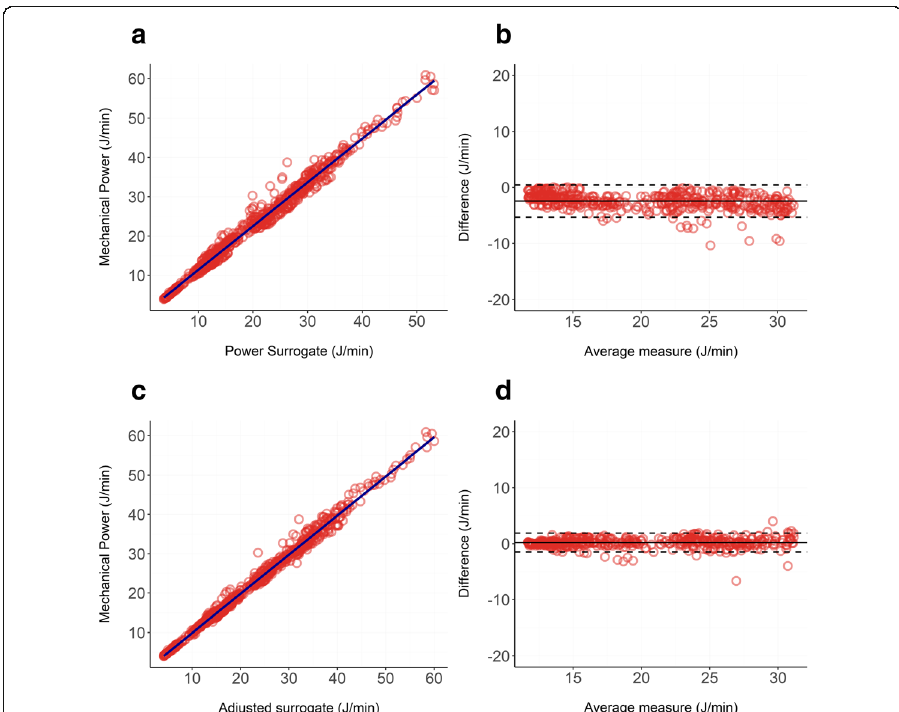
Fig. 3 a , b : Relationship between our unadjusted surrogate of mechanical power (Eq. 3) and the reference formula (Eq. 1) in pigs: panel a shows the linear regression ( R 2 = 0.98), and panel b shows the Bland-Altman (bias = − 2.45 J/min; proportional error = − 0.09 J/min). c , d Relationship between our adjusted surrogate of mechanical power (Eq. 9) and the reference formula (Eq. 1) in pigs: panel c shows the linear regression ( R 2 = 0.99), and panel d shows the Bland-Altman (bias = 0.21 J/min; proportional error = 0.01